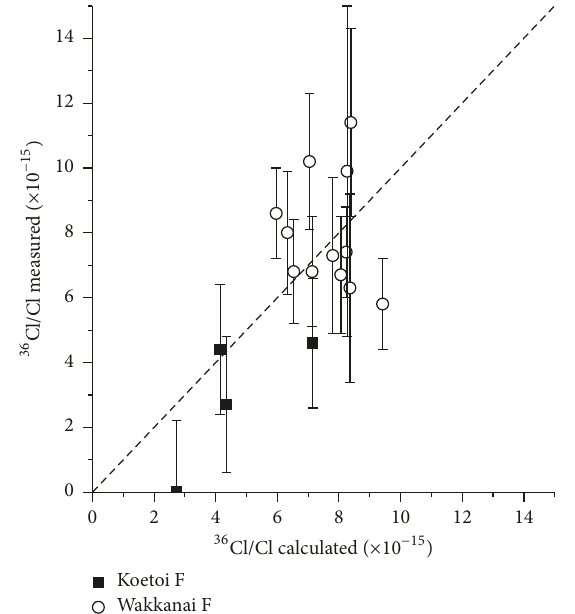
Figure 10: Comparison of calculated ( 36 Cl/Cl) 36 Cl/Cl; the dashed line in the figure is the line of 𝑦 = 𝑥